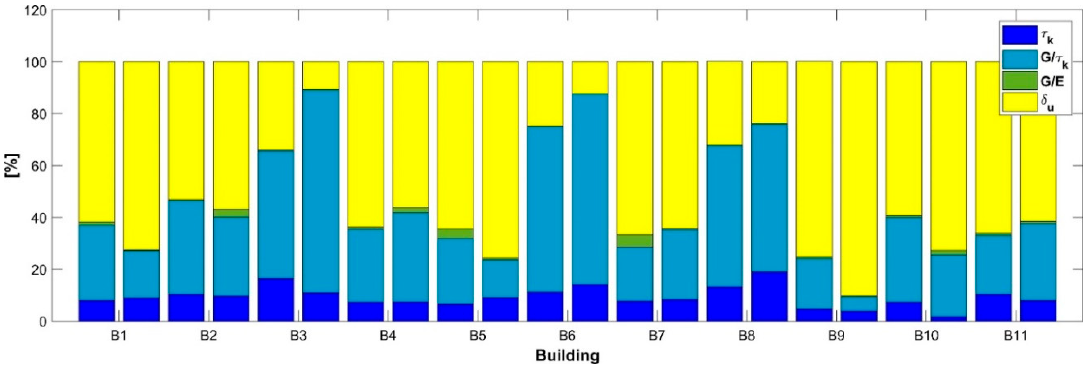
Figure 11. Sobol indices for τ k , G / τ k , G / E and δ u in the investigated buildings.